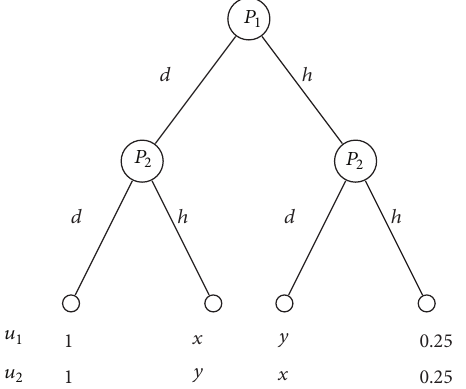
Figure 1: The conflict game with perfect information.